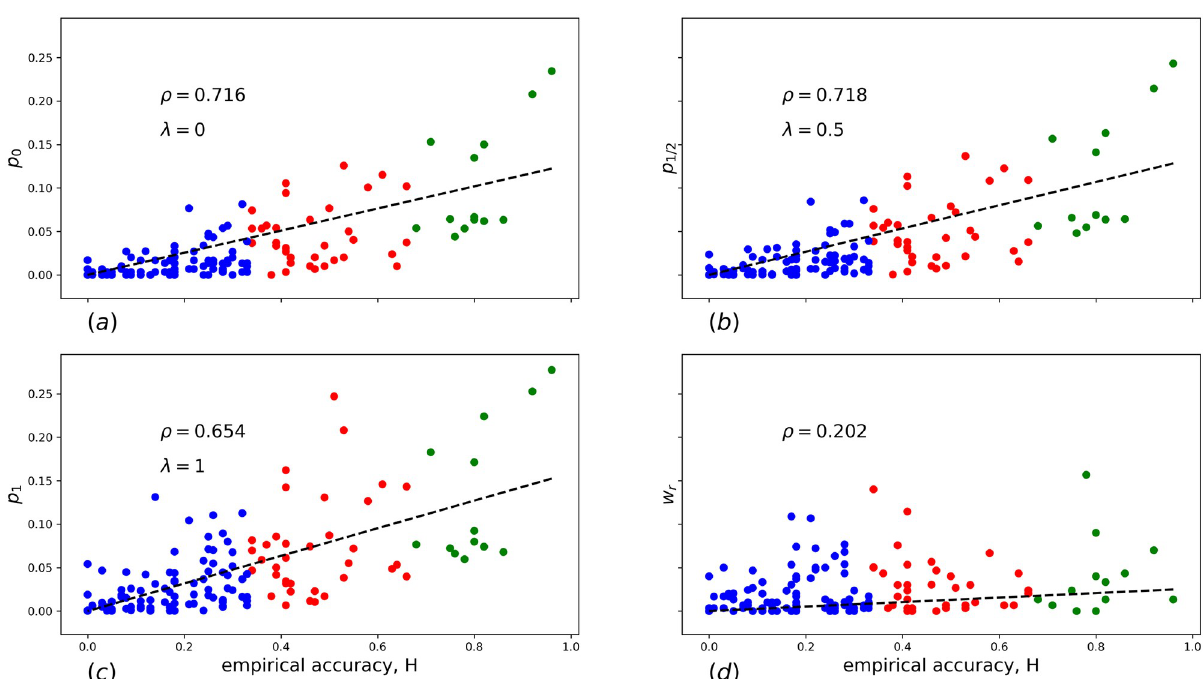
Fig 2. The scatter plots of the empirical accuracy of the RAT solution versus following variables: (a) the average association weight from the stimuli words to the response p 0 ( α ); (b) the estimated probability of random walk with resetting with λ = 1/2, p 1/2 ( α ); (c) the estimated probability of unlimited ( λ = 1) random walk, p 1 ( α ); (d) the average association weight from the response to the stimuli words w α . In all figures ρ is the Pearson correlation